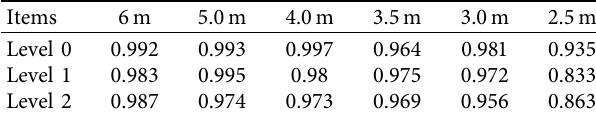
Table 6: Test results of beam bridge (crosswind, side).